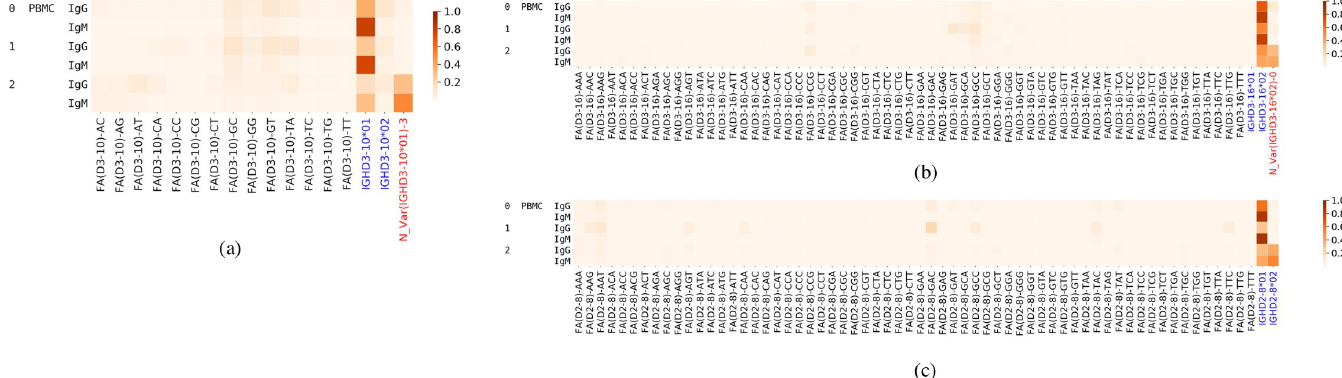
Fig 8. Allelic variant usage for genes IGHD3-10 (a), IGHD3-16 (b) and IGHD2-8 (c). FA stands for false alleles. The alleles listed in IMGT are shown in blue. Novel inferred genes are shown in red.